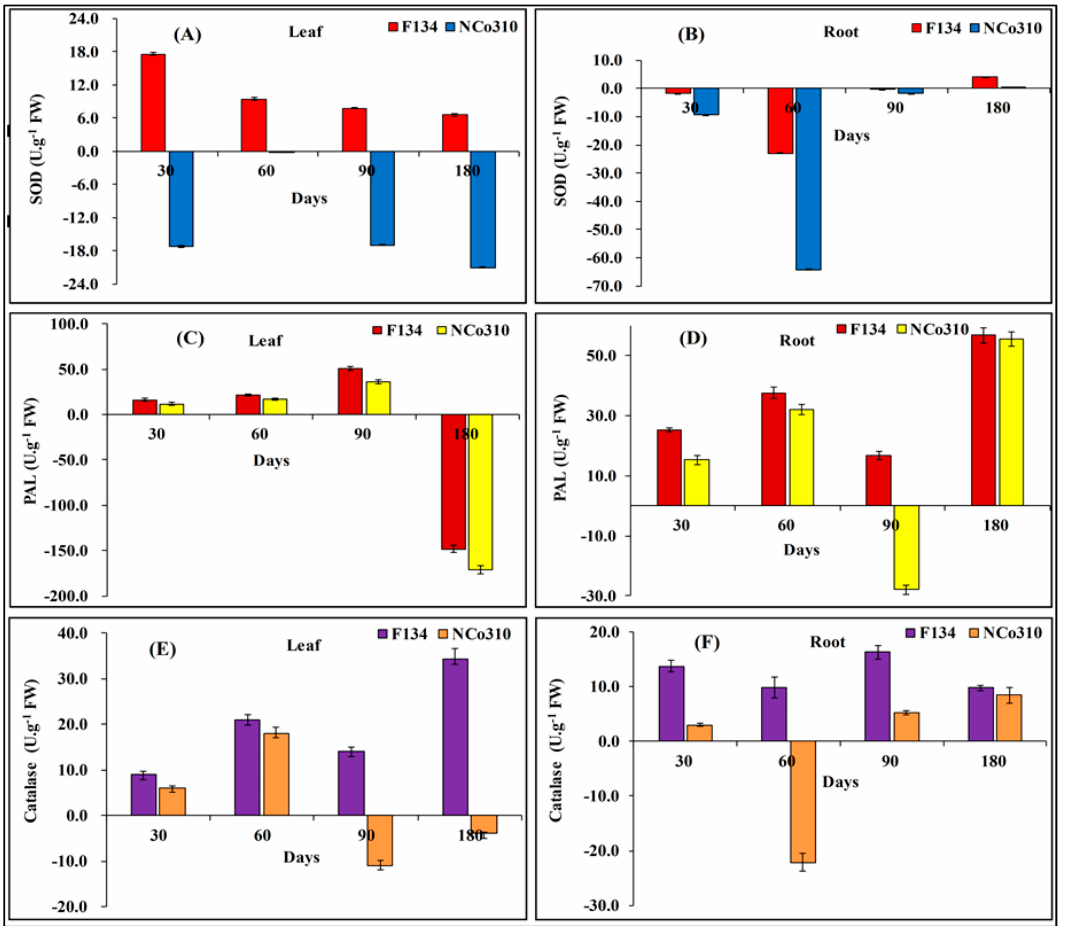
Figure 4. Analysis of enzyme activities in leaf and root tissues of sugarcane varieties F134 and NCo310 infected with S. scitamineum stress. ( A , B ) Superoxide dismutase, ( C , D ) phenylalanine ammonia lyase, and ( E , F ) Catalase. All data points (with the subtraction of their controls) are the mean ± SE ( n = 3).